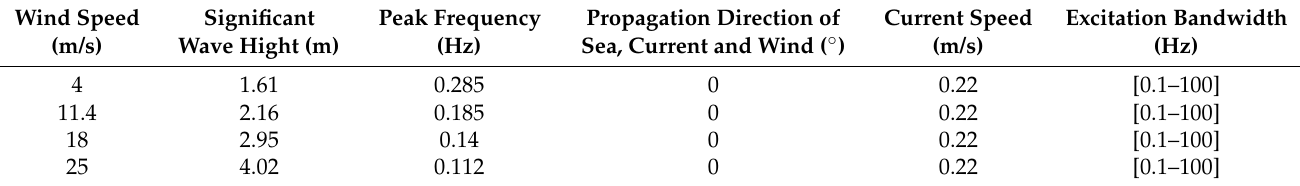
Table 1. The varying EOC